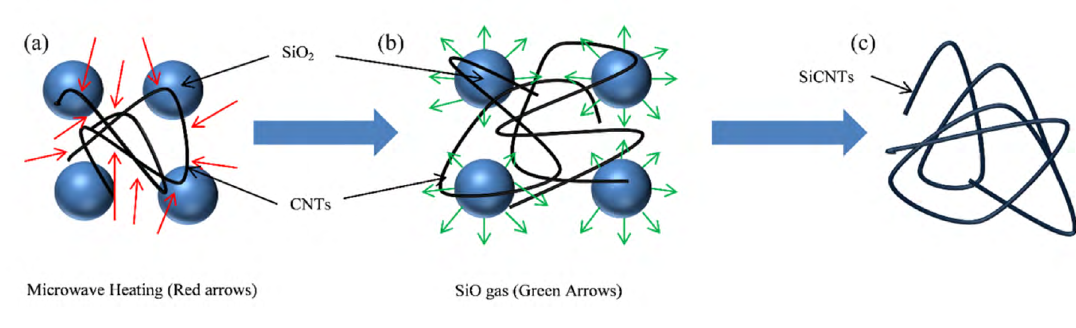
and MWCNTs in the ratio of 1:1, 1:3, 1:5 and 1:7 during 2